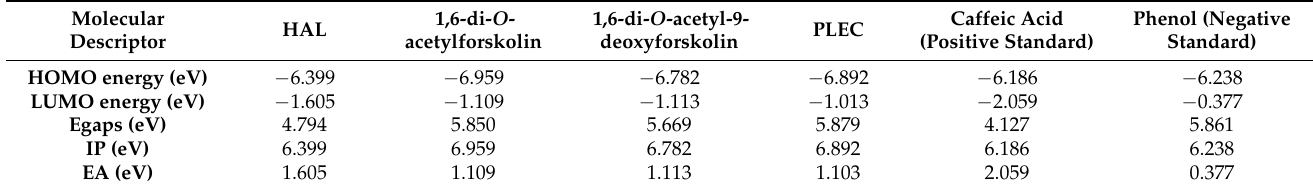
Table 3. Energy of HOMO/LUMO orbitals, Egaps and other reactivity